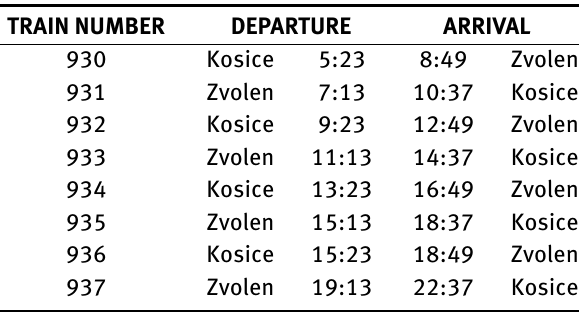
Table 1: Train timetable on the route Kosice – Zvolen (source: au-